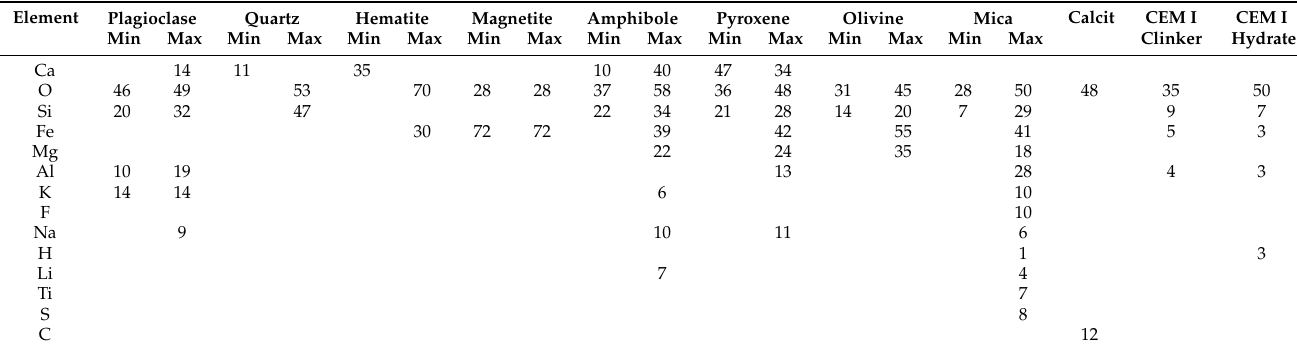
Table 2. Element distribution weight percentage (wt.%) of major minerals that compose aggregates and cement type I (empty spaces mean no or a negligible content).